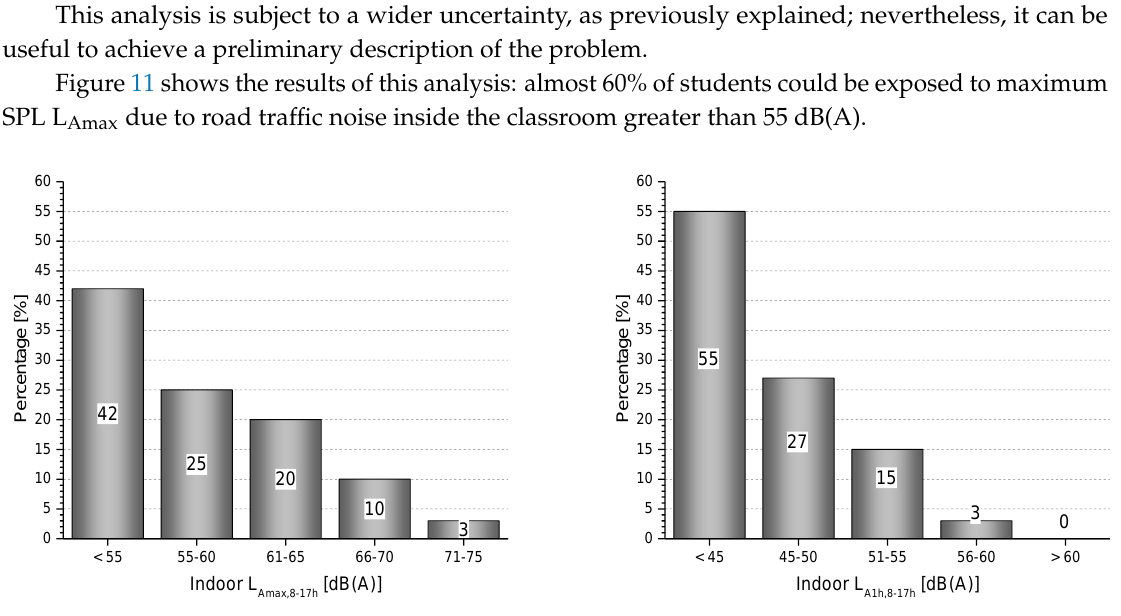
Figure 11. Distribution of the maximum (L Amax ) and statistical (L A1 ) SPL inside the classrooms estimated for the students of primary and lower secondary schools of Florence.